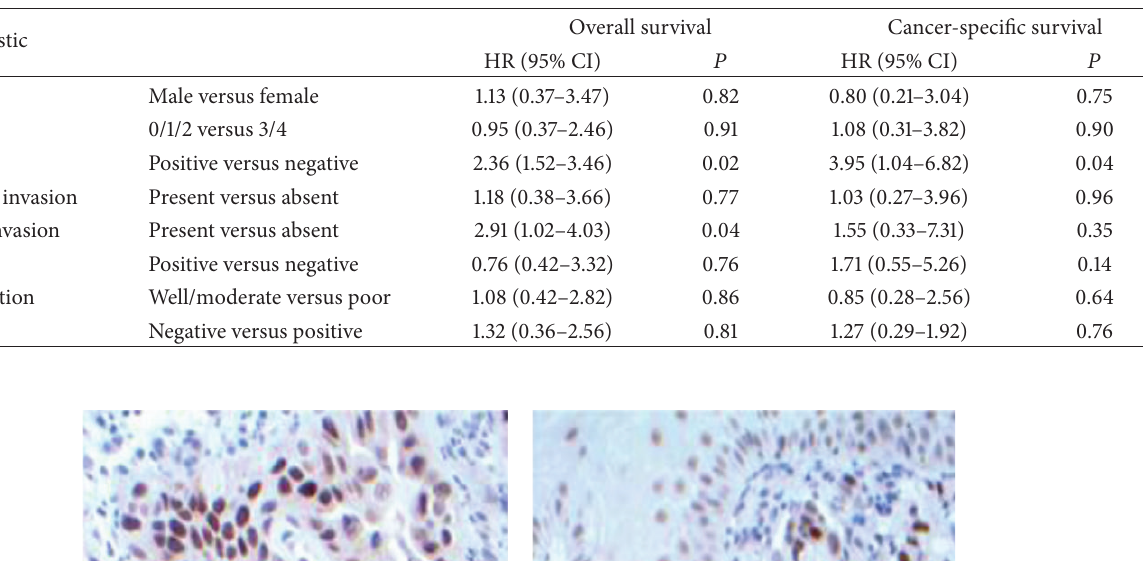
Table 3: Univariate analysis of clinicopathological factors.